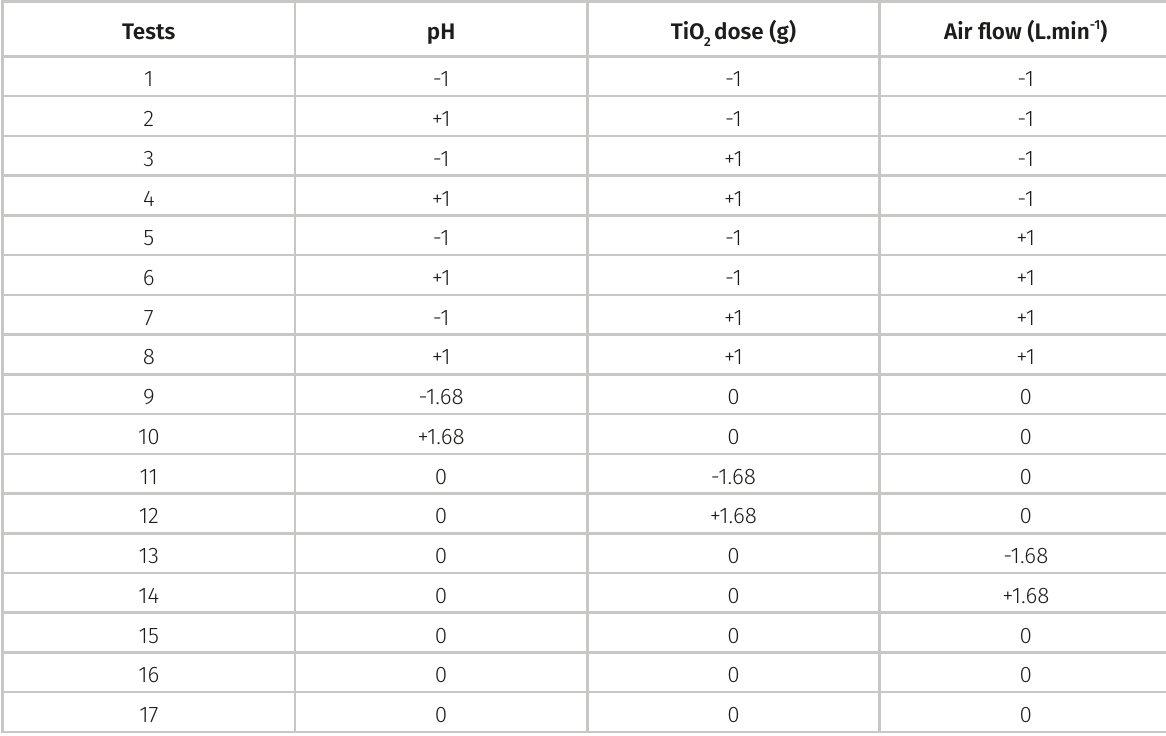
Table IV . CCRD planning matrix (2³) with the coding of operational variables